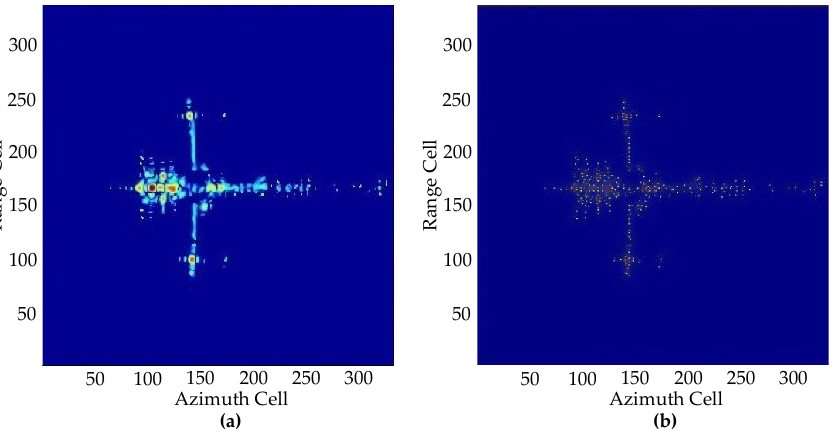
Figure 12. Imaging results of Yak42 under sparse aperture: ( a ) IFFT; ( b ) GAN1; ( c ) GAN2; ( d ) GAN3; ( e ) Proposed GAN. Table 8. Numerical performance evaluation for Yak42 under sparse aperture.